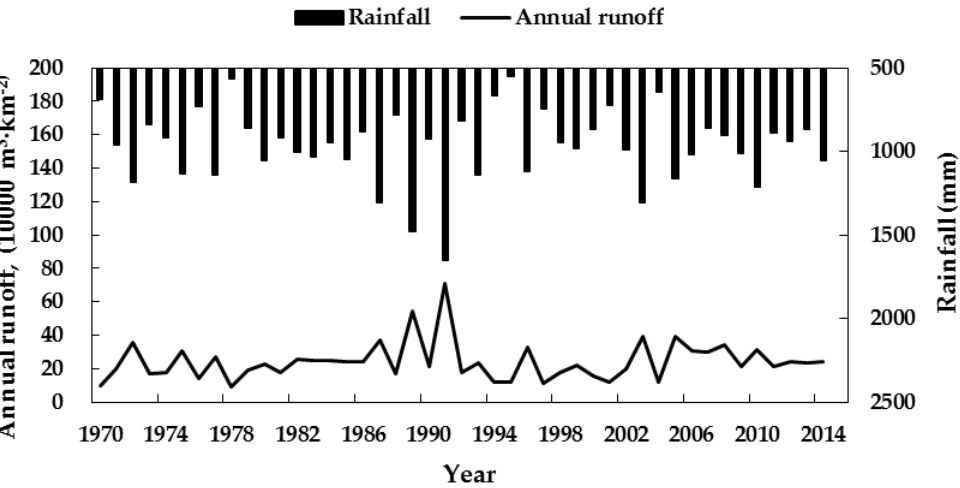
Figure 2. Simulated annual runoff for the Yangdian Town pond irrigation district from 1970–2014.